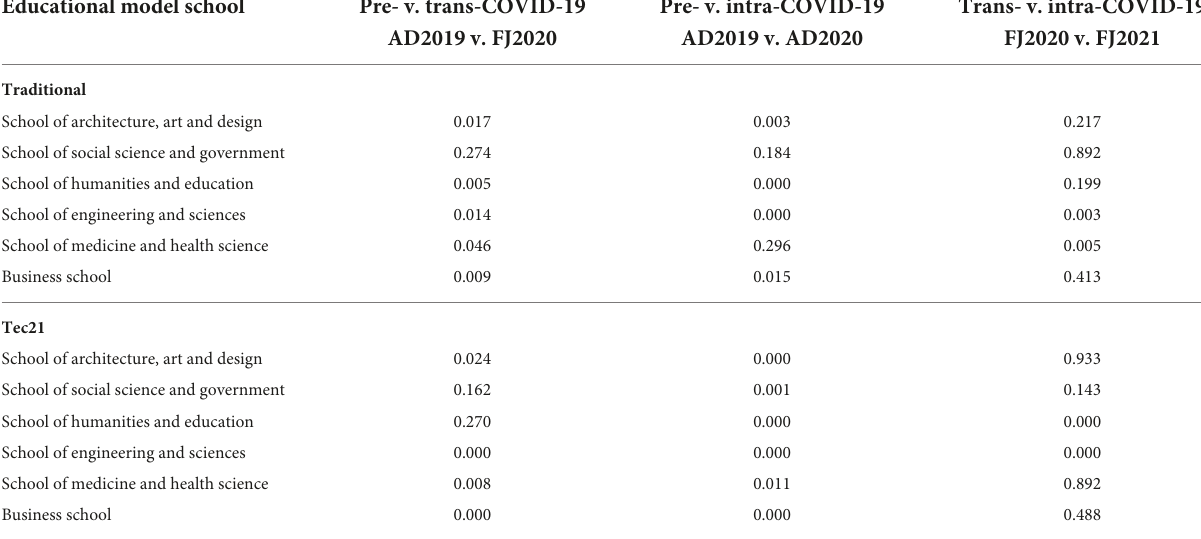
TABLE 3 Statistical significance ( p -value) of two-tailed t -test comparison between COVID-19